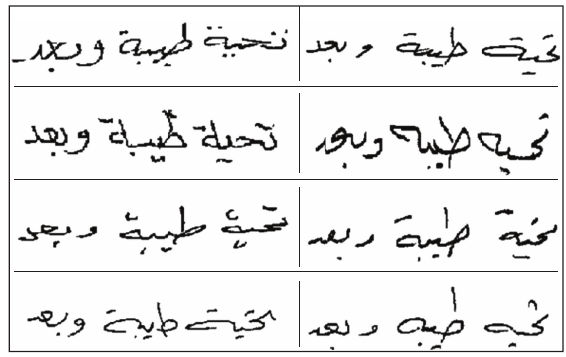
Figure 1: Handwriting by eight di ff erent